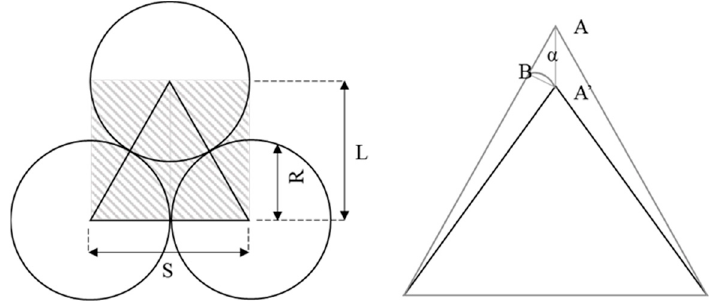
Figure 4. Basic Mechanical Unit of HCP Ball Array.